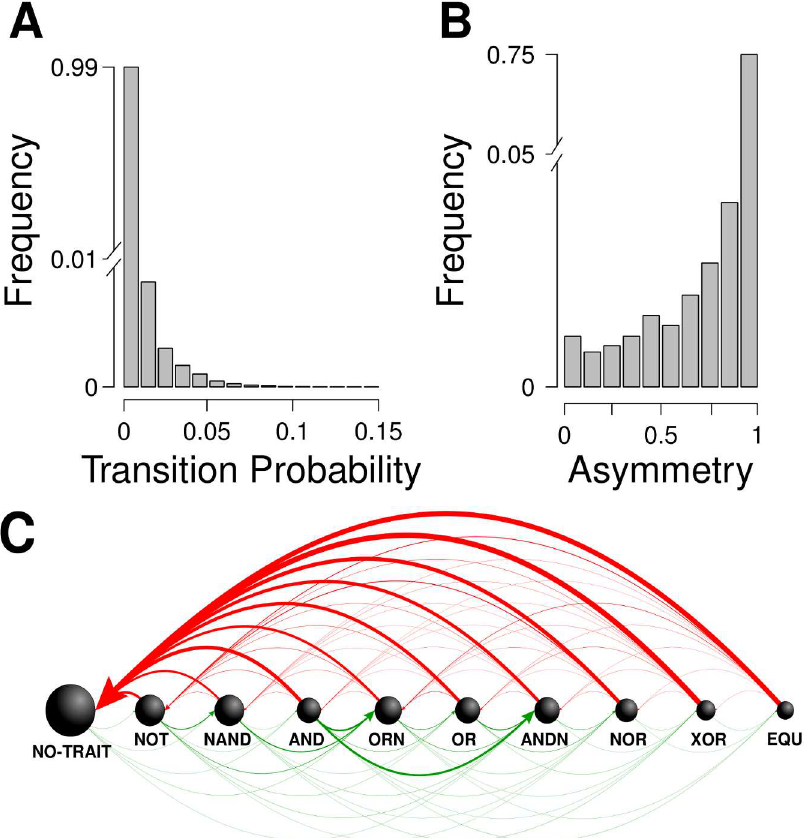
Fig 3. Most phenotypic transitions are rare and asymmetric. (A) Distributionof transition probabilities from phenotype i to any other phenotype j , computedas the fraction of all genotypes with phenotype j that lie in the 1-mutant neighborhoods of organisms with phenotype i . Most transition probabilities are very low. (B) Distributionof the asymmetry AS ( i , j ) of the transition probabilities betweenall pairs of phenotypes i and j . Most reciprocal transition probabilities are highlyasymmetric. (C) Transitions betweensingle-traitphenotypes (i.e., phenotypes whose organismshave only one single trait) as well as merely viable organisms (labeledas no-trait). Nodes representphenotypes(arrangedin order of increasing complexity from left to right) and arrows depict transition probabilities. Node size is scaled to the logarithmof phenotypicrobustness (i.e., the fraction of 1-mutant neighborswithout altered phenotype). Transitionsfrom phenotype i to phenotype j , where j is more (less) complex than i are depictedby green (red) arrows. The thickness of an arrow betweentwo nodesis proportional to the transition probabilitybetweenthe phenotypes represented by that pair of nodes. (Green arrows are drawn 10 times thicker than red ones for visualizationpurposes.). The figure illustrates that (i) it is generallyharder for a simple phenotype i to reach a more complexphenotype j than vice versa; (ii) the only way to encounterthe most complexsingle-traitphenotype (EQU) from the least complex one of mere viability(bottom) requiresgoingthrough at least two phenotypes of intermediate complexity(e.g., to NOT, AND, and from there to